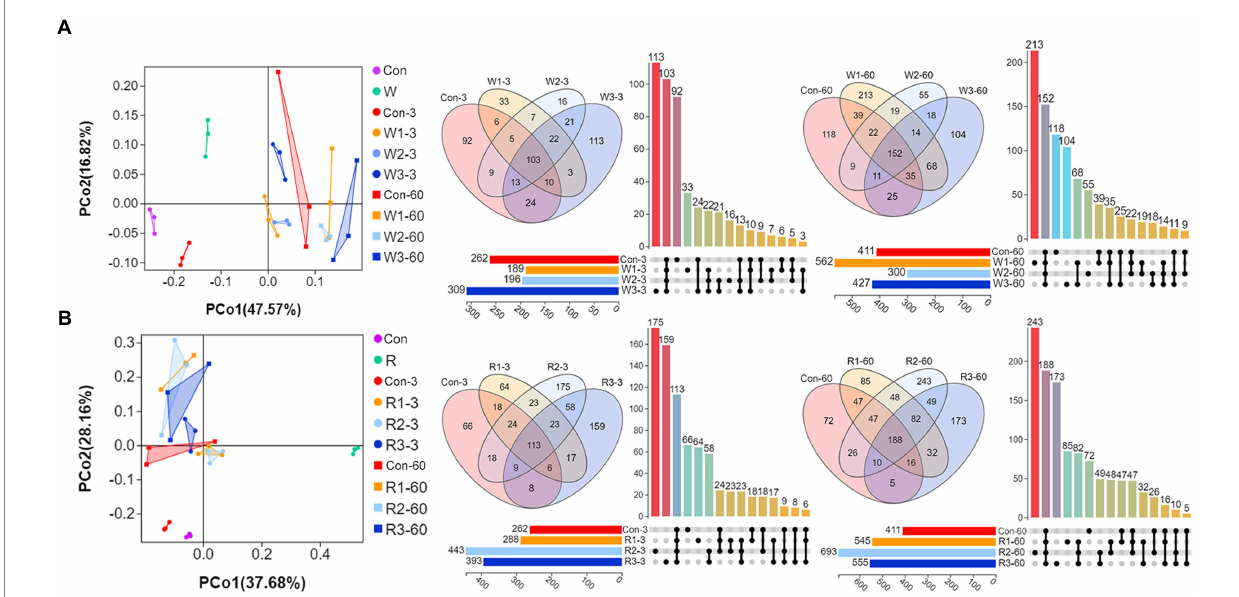
FIGURE 4 PCoA, Venn diagrams and UpSet plot of bacteriome during the anaerobic fermentation of Chinese cabbage waste. The control group (Con). Chinese cabbage waste was mixed with (A) wheat bran at a mass ratio of 383:117 (W1), 353:147 (W2), and 323:177 (W3) or with (B) rice bran at 387:113 (R1), 358:142 (R2), and 329:171 (R3), respectively; 3 and 60 mean day 3 and day 60, respectively.